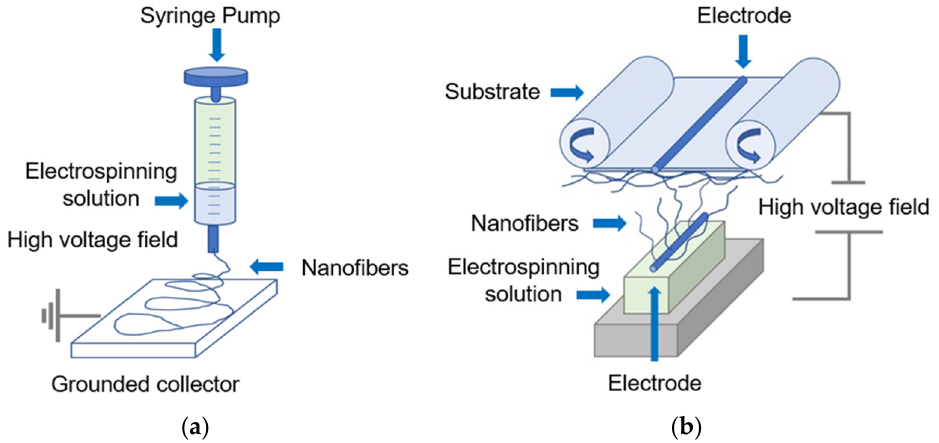
Figure 3. Overview of needle-based ( a ) and needle-free ( b ) electrospinning technologies. Adapted from [60], originally published under a CC-BY license.